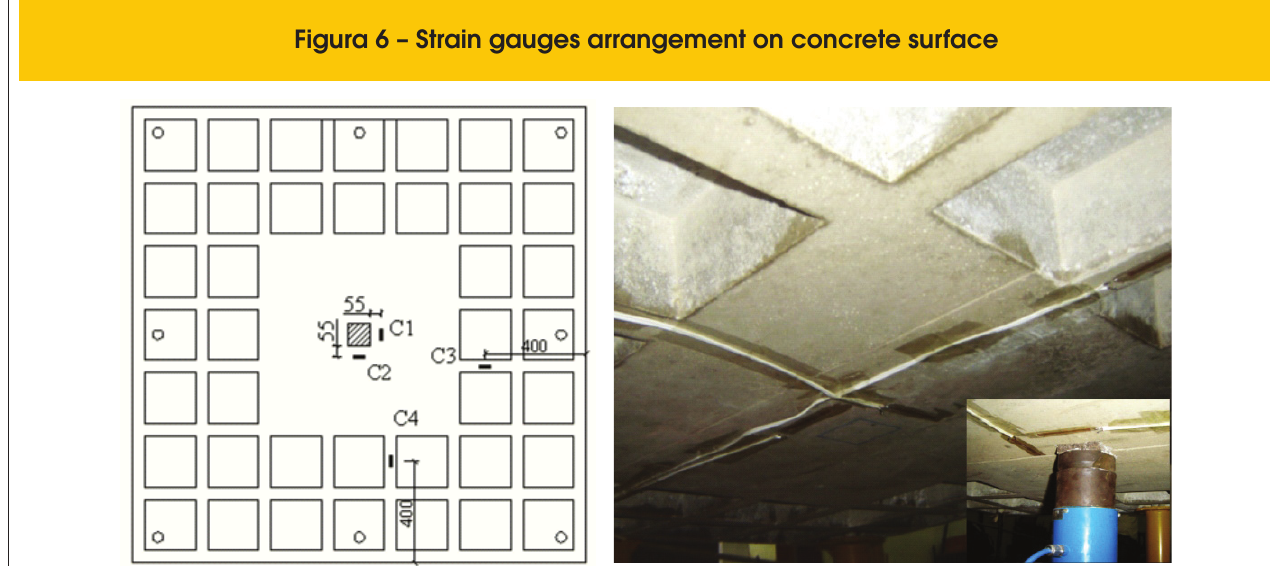
Figura 6 – Strain gauges arrangement on concrete